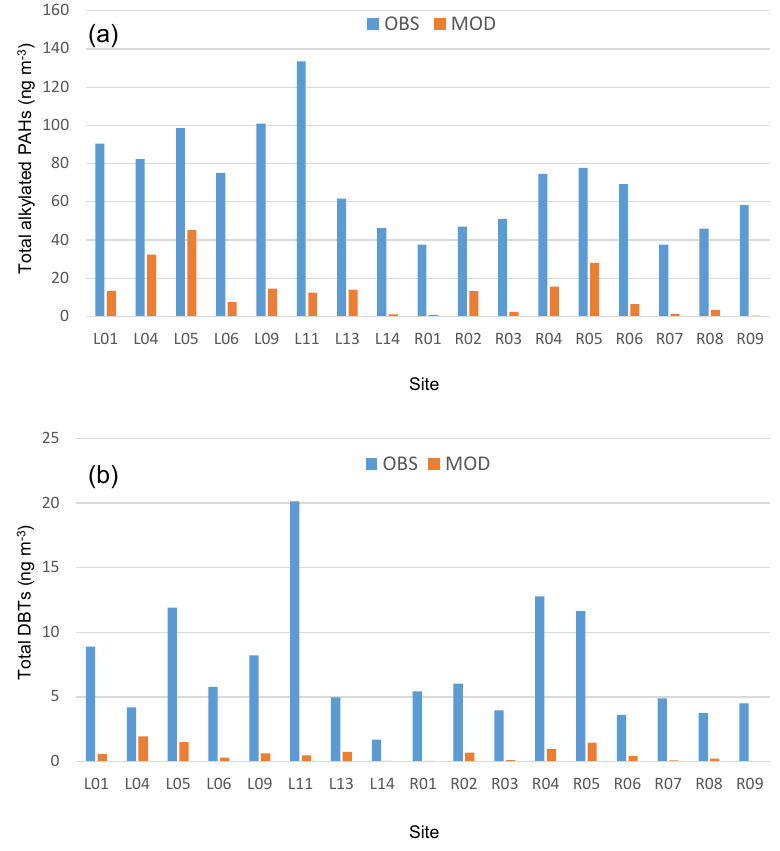
Figure 4. Comparison of average concentrations of total alkylated PAHs (a) and DBTs (b) between passive measurements (OBS) and model (MOD) using the JOSM-derived